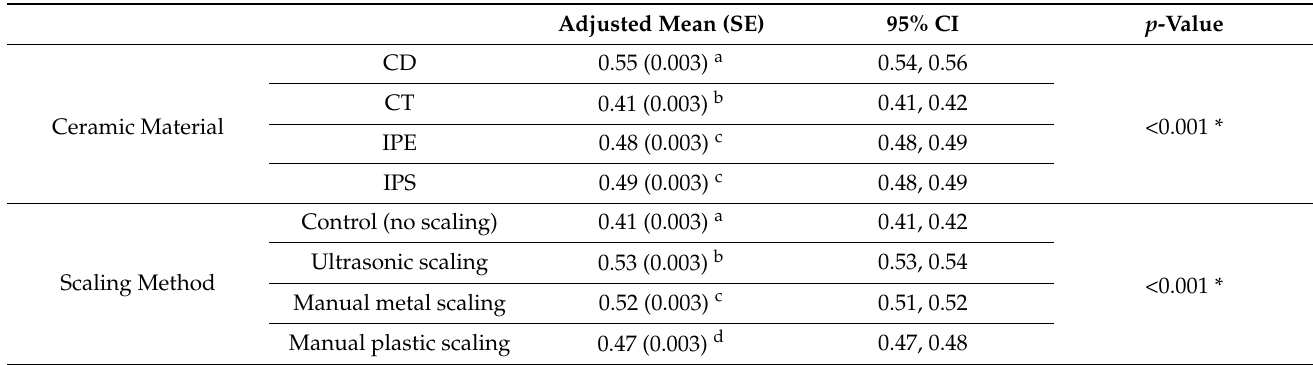
Figure 6. Surface roughness (Ra) of manual plastic scaling of each: ( a ) CD, ( b ) CT, ( c ) IPE, and ( d ) IPS. CD; zirconia-reinforced lithium silicate (Celtra Duo). CT; advanced lithium disilicate (CEREC Tessera). IPE; lithium disilicate (IPS Emax CAD). IPS; leucite-reinforced (IPS Empress CAD). Table 1 represents the association of the ceramic composition and scaling method with surface roughness. Regarding the ceramic materials, there was a significant difference between the studied ceramics’ compositions ( p < 0.001). CD showed a significantly higher surface roughness than the other groups (adjusted mean = 0.55), while CT showed the lowest roughness values (adjusted mean = 0.41). No significant difference was detected between IPE and IPS (adjusted means = 0.48 and 0.49, respectively). As for the scaling methods, there were significant differences in the surface roughness between the different methods ( p < 0.001). The highest roughness values were reported after ultrasonic scaling, followed by manual metal and plastic scalers (adjusted means = 0.53, 0.52, and 0.47, respectively), while the lowest values were reported for samples not exposed to any scaling method (adjusted mean = 0.41). Table 1. Two-way ANOVA for the association of different factors with surface roughness.